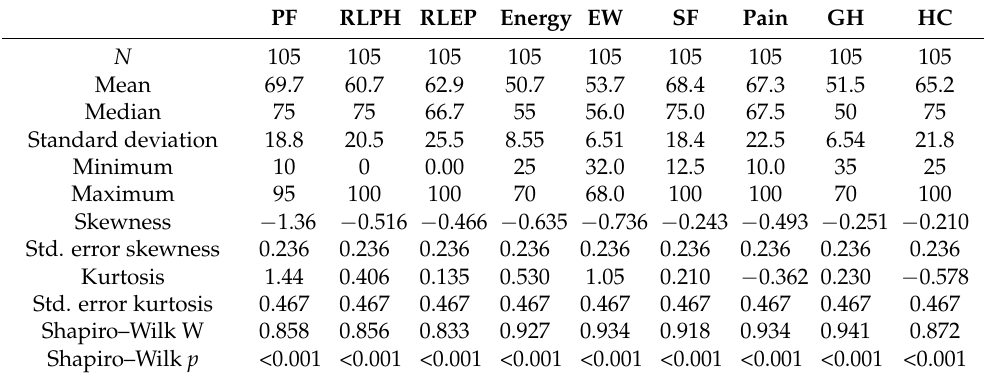
Table 2. SF-36 Descriptive statistics of subgroups of Short Form 36